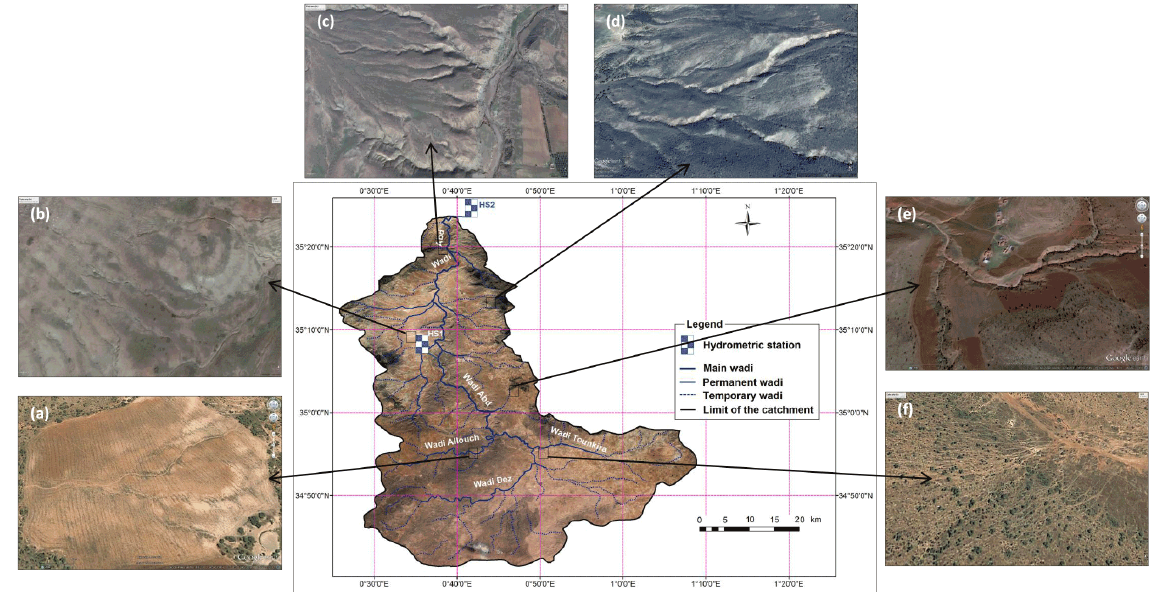
Figure 3. Linear erosion forms in the Wadi Abd basin. (a) and (e) display gullying (depth: 30–50cm, width > 1m), (c) and (d) gully erosion (depth: 50–200cm), (b) and (f) interill and rill erosion.